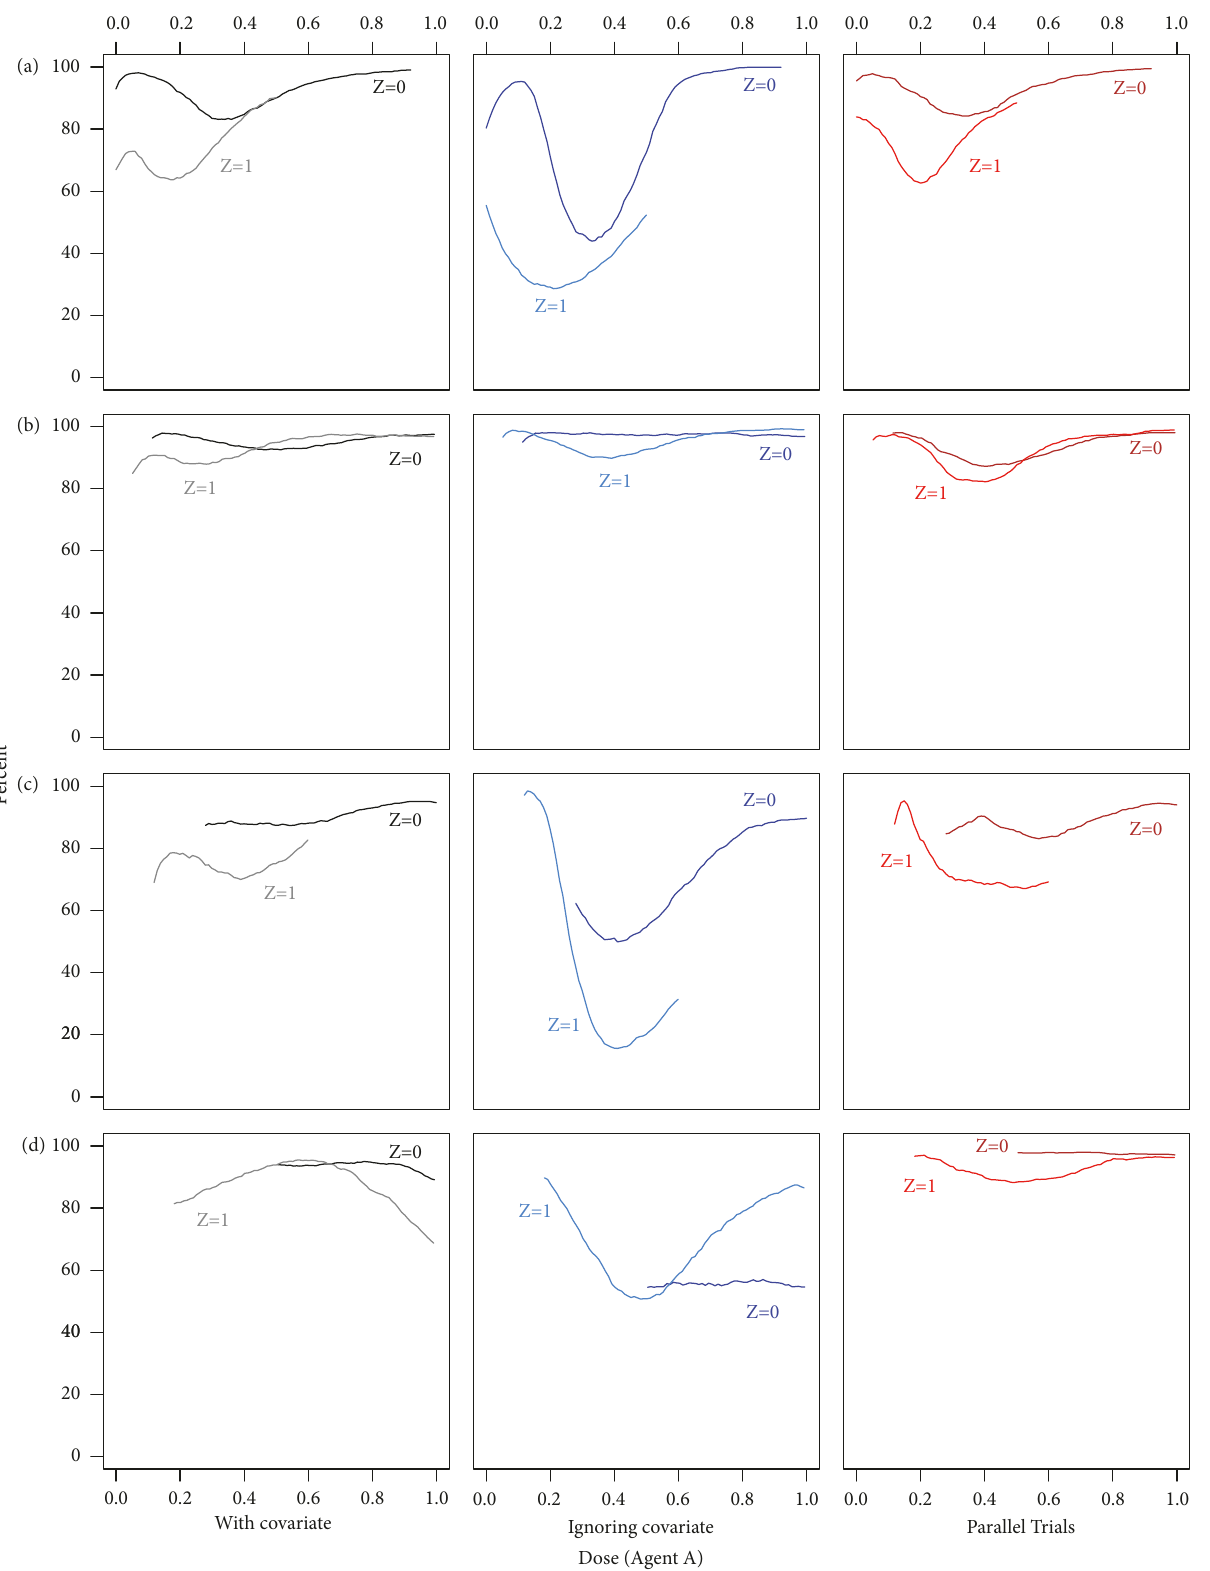
Figure 3: Pointwise percent of MTD recommendation for 𝑝 = 0.2 with designs using a covariate (WC), ignoring the covariate (IC), and parallel trials (PT) under scenarios